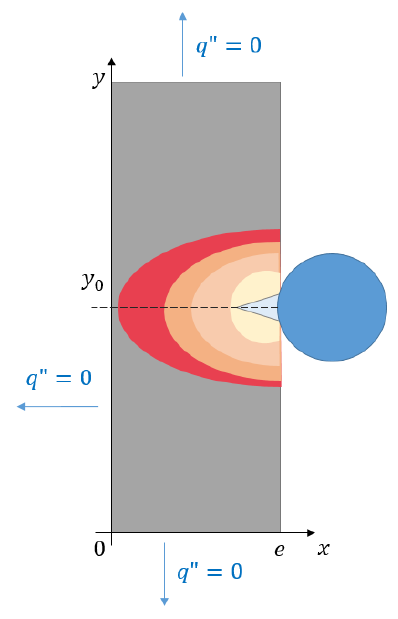
Figure 16. Diagram of the 2D model with a bubble growing on y = y 0